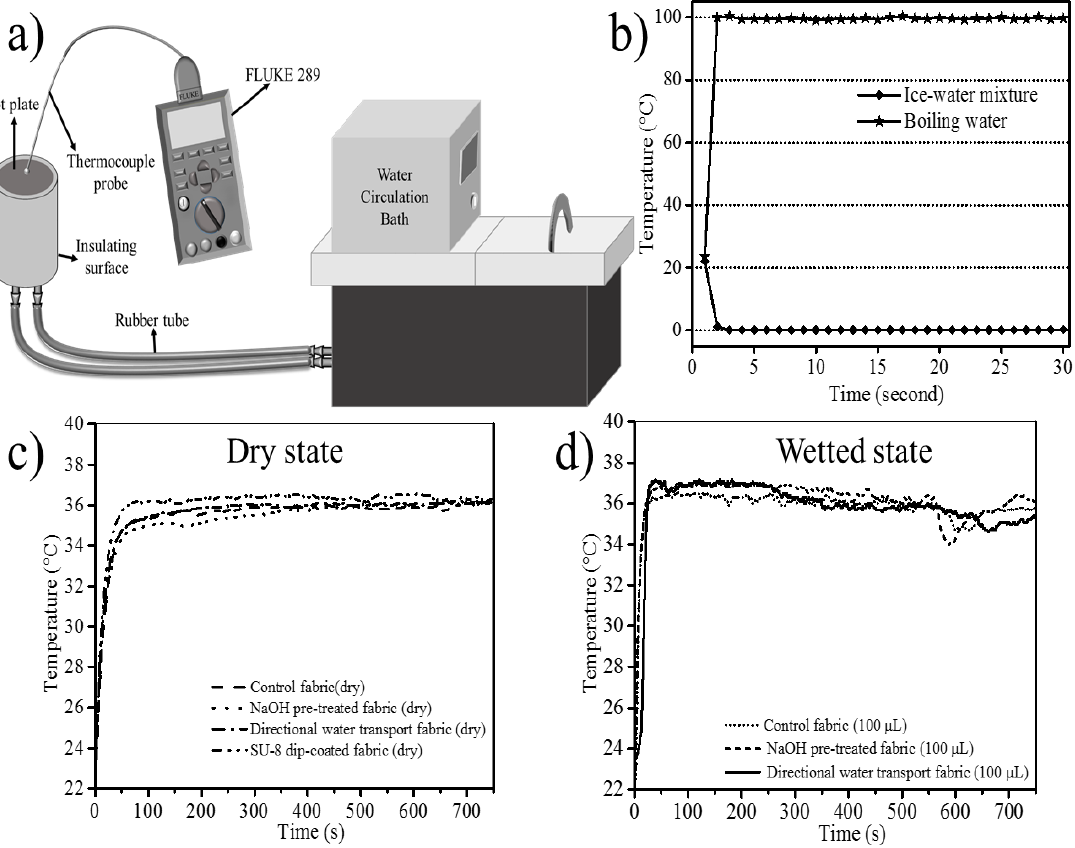
Figure 3. ( a ) Schematic of the purpose-built setup for measuring the heat transfer property of fabrics; ( b ) temperature of boiling water and ice-water mixture measured by thermocouple; and ( c , d ) temperature–time curves of the NaOH pre-treated fabric, directional water transport fabric and SU-8 dip-coated fabric in dry ( c ) and wetted ( d ) states.